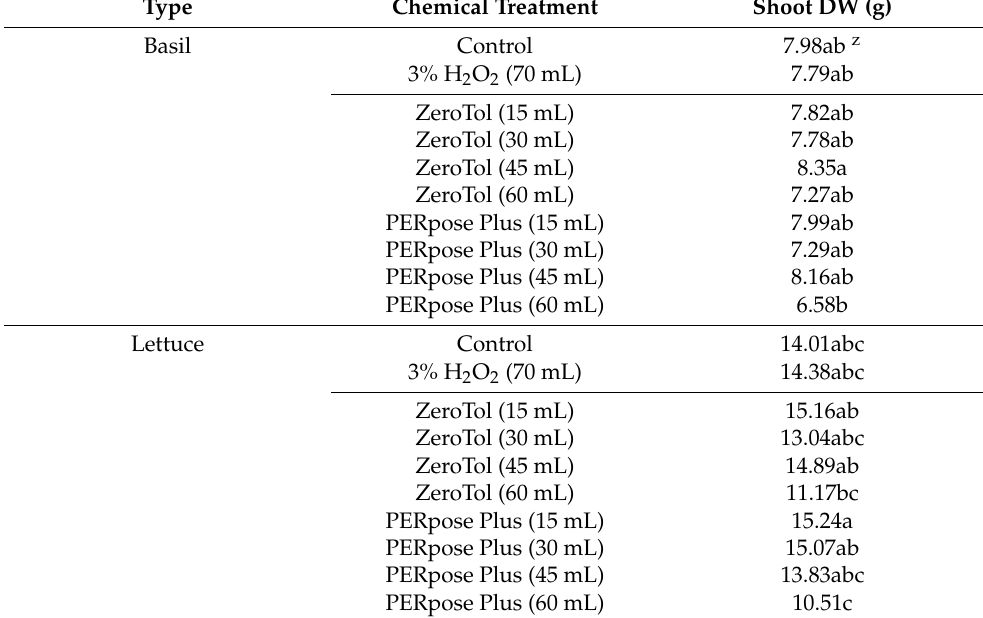
Table 6. The least square means of rates of two hydrogen peroxide products on growth of basil (‘Genovese’ and ‘Aroma II’) and lettuce (‘Green Forest’ and ‘Tropicana’) grown in the ebb and flow hydroponic systems at OSU research greenhouses in Stillwater, OK. Experiment